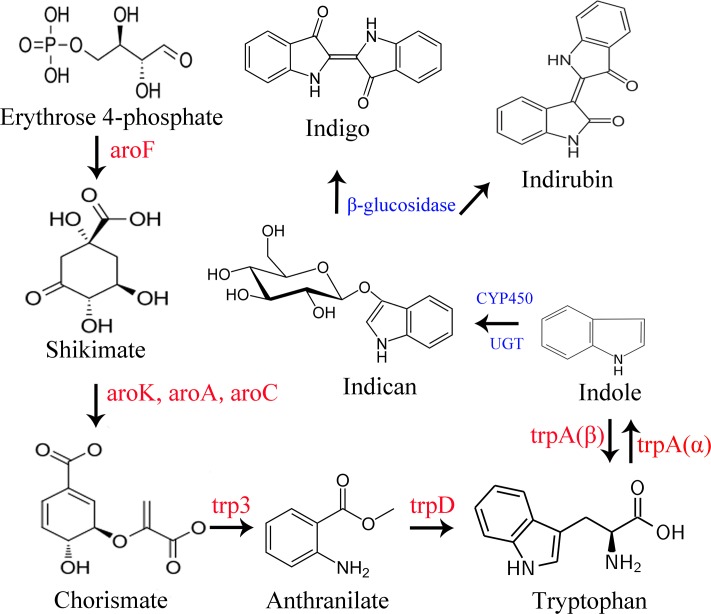
Pathway of phenylalanine, tyrosine and tryptophan biosynthesis and putative pathway of indican biosynthesis and metabolism.The red word in the figure shows the genes involved in tryptophan biosynthesis, the blue shows the genes involved in indican biosynthesis and metabolism. aroF: 3-deoxy-7-phosphoheptulonate synthase; aroK: shikimate kinase; aroA: 3-phosphoshikimate 1-carboxyvinyltransferase; aroC: chorismate synthase; trp3: anthranilate synthase; trpD: anthranilate phosphoribosyltransferase; trpA: tryptophan synthase.